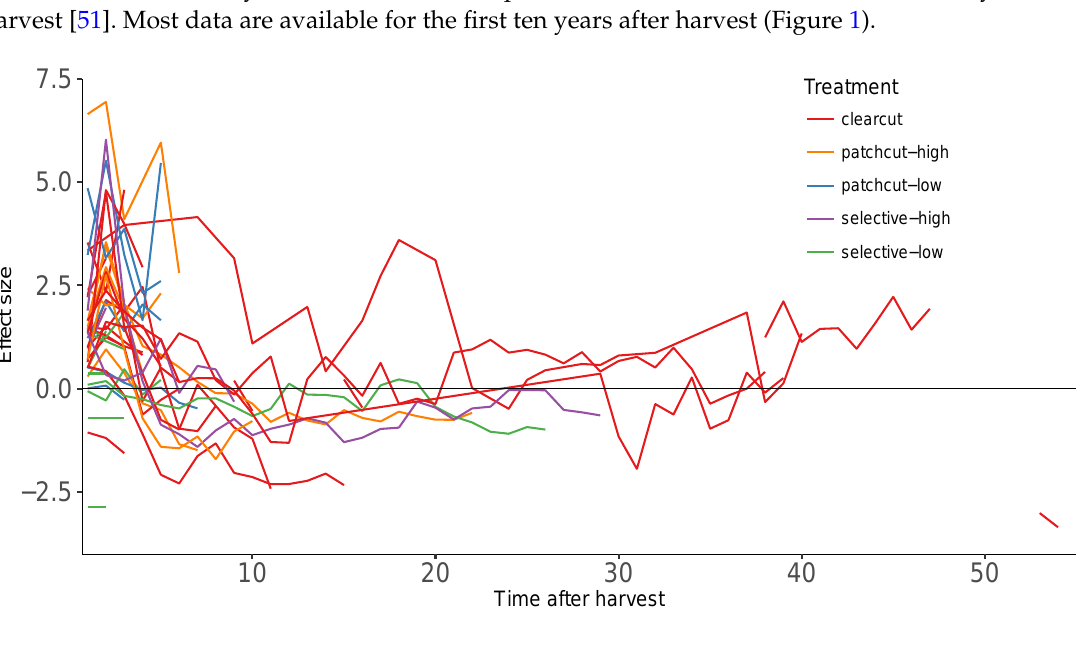
Figure 1. Standardized mean difference of stream nitrate concentrations plotted against post-harvest time series. Colours reflect the different harvest types. Most long-term studies were clearcut treatments. Seven studies had records for more than fifteen years after